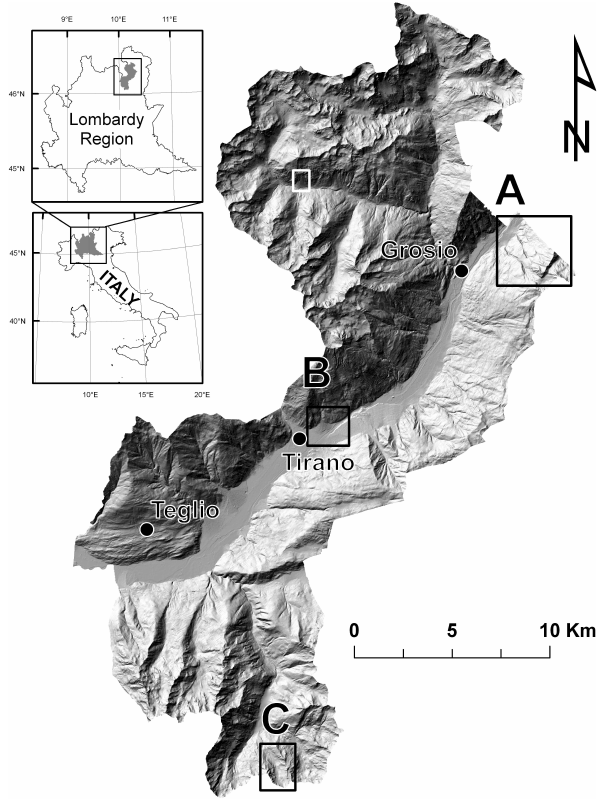
Fig. 1. Hillshade map of the study area. The white rectangle shows the location of Fig. 4, the black rectangles show locations presented on Fig. 7 (A, B,